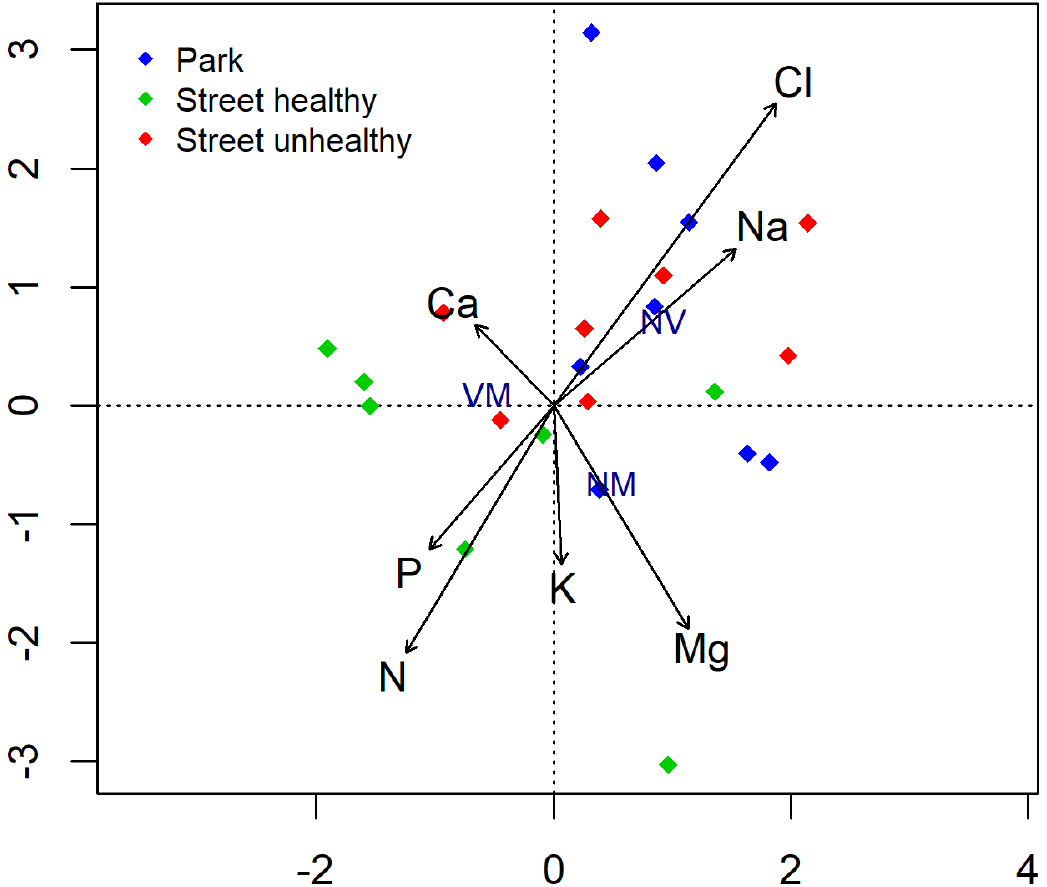
Figure 4. Biplot for canonical correspondence analysis (CCA) used to show relationship between the abundance of different root tip types (vital mycorrhizal (VM), non-vital (NV), and vital non-mycorrhizal (NM)) and the chemical composition of leaves.